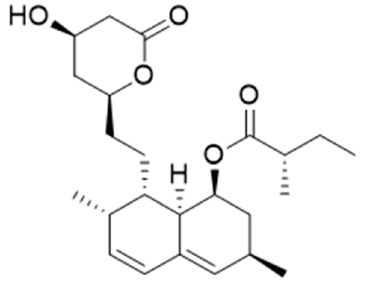
Figure 3. Chemical structure of lovastatin.